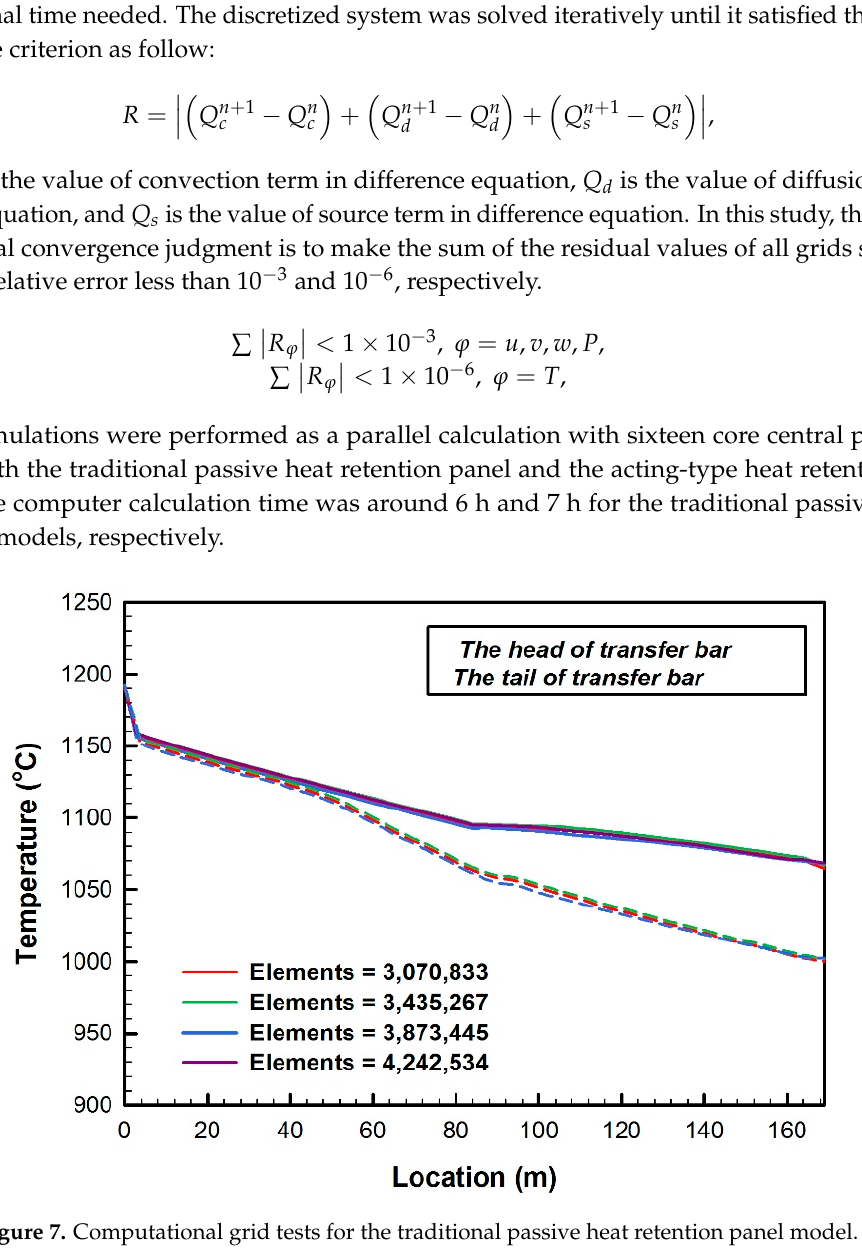
Figure 7. Computational grid tests for the traditional passive heat retention panel model .